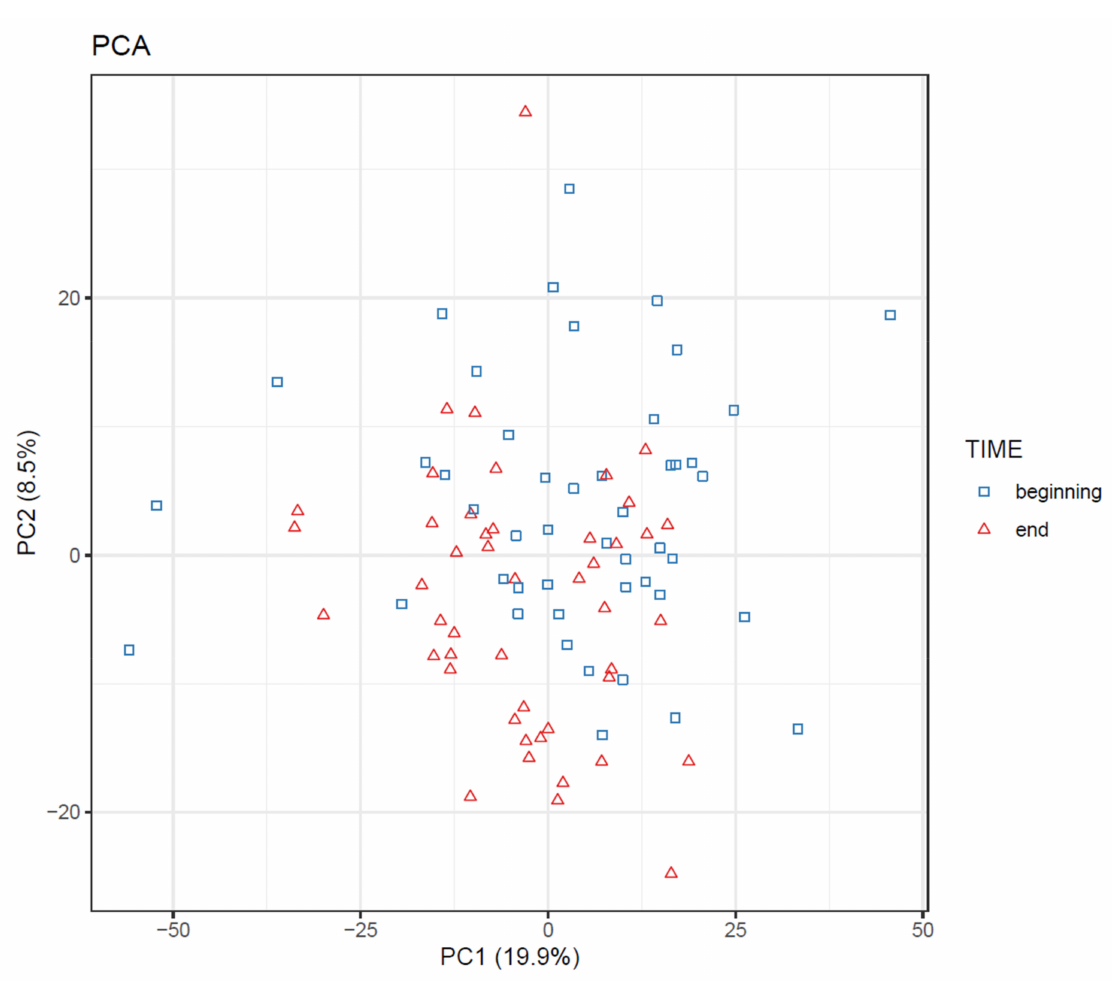
Figure 18. Principal component analysis (PCA) plot of samples from an intervention study, before and after the intervention. The time points are somewhat separated, but no clear clusters or outliers are